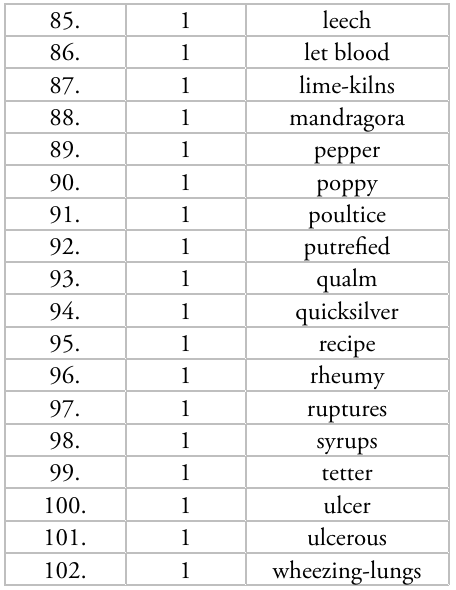
Table 5: Names of illnesses, cures and healers in the nine-play